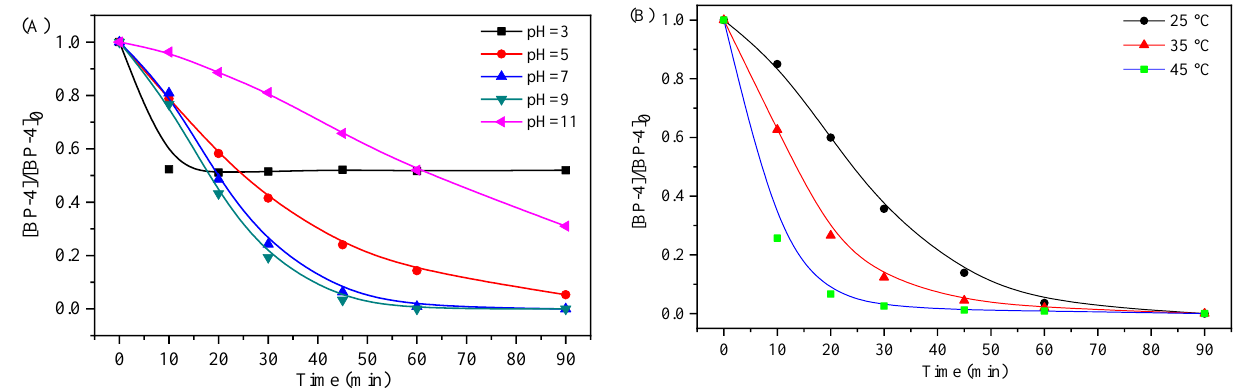
Figure 2. Effect of initial solution pH ( A ) and temperature ( B ) on BP-4 removal by Fe(VI) (experi- mental conditions: [BP-4] 0 = 5 mg/L; T = 25.0 °C for pH (initial pH 7.0 ± 0.2 for temperature); [Fe(VI)] 0 :[BP-4] 0 = 100:1; reaction time = 90 min).